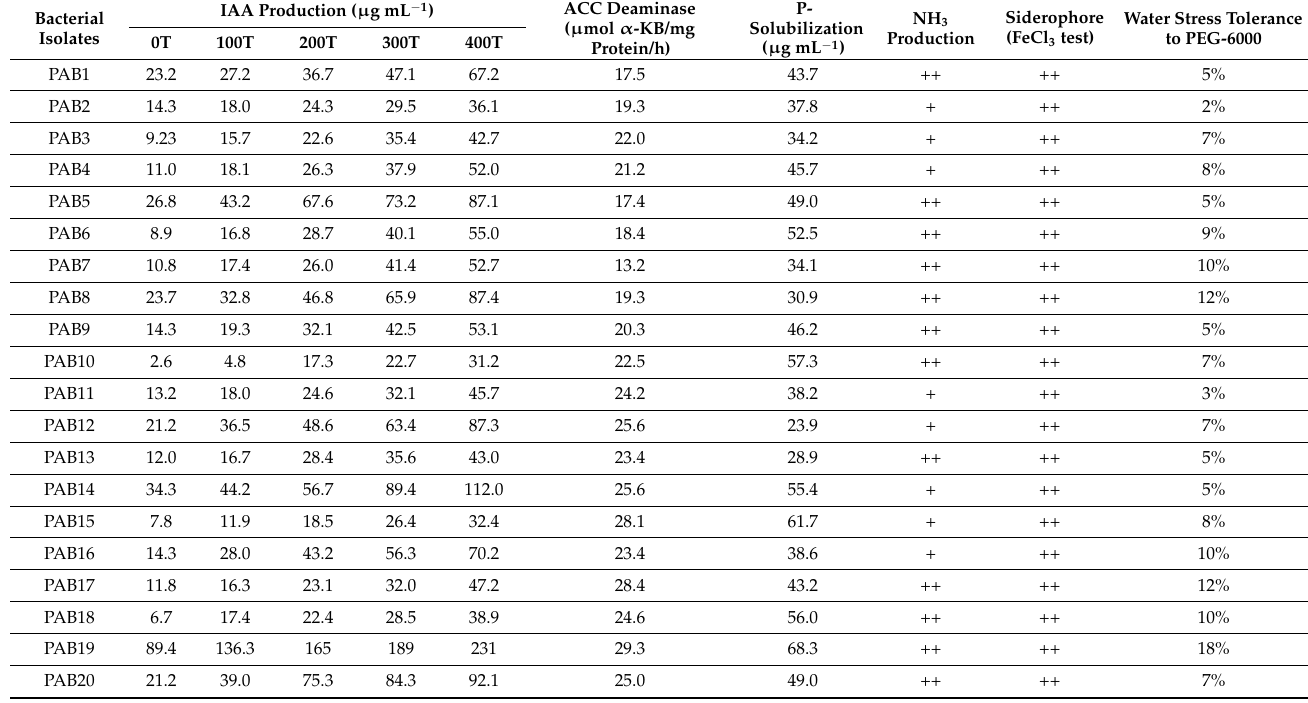
Table 1. Plant growth-promoting features of the PGPR isolates (PAB1 to PAB20) recovered from rhizosphere soils and their tolerance to water stress (PEG-6000). Bacterial